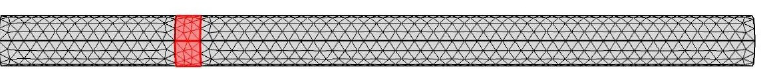
Figure 1. Model and mesh of Rijke tube.